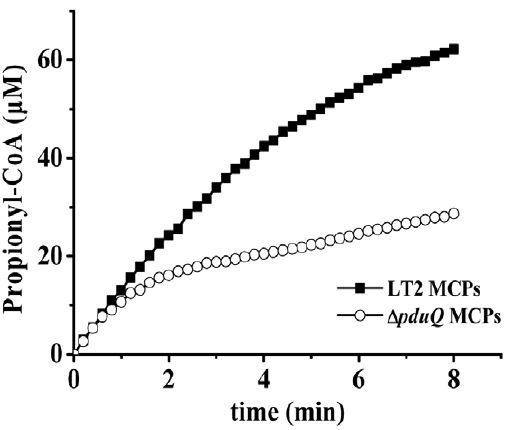
Figure 6. PduQ regenerates NAD + for the PduP reaction in purified Pdu MCPs. The PduP activity of purified MCPs was measured by monitoring the absorbance increase at 232 nm due to propionyl- CoA formation. Limiting NAD + (40 m M) was added in the assays. The propionyl-CoA produced by wild-type MCPs and D pduQ MCPs, respectively, reached 62.3 and 27.6 m M in 8 min. Because the concentration of propionyl-CoA produced by the wild-type exceeded the amount of NAD + added to the reaction (the PduP reaction produces 1 NADH per propionyl-CoA formed) recycling of NADH to NAD + is indicated.